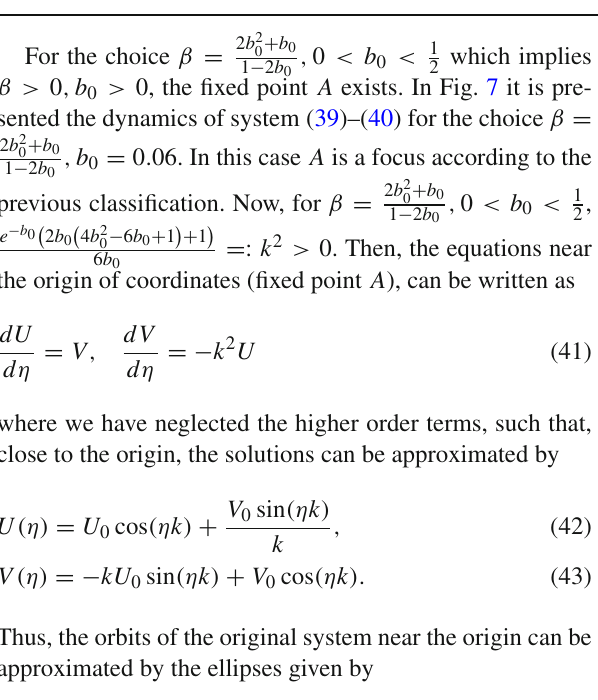
+ b 0 2 , b = 0 0 1 − 2 b 0